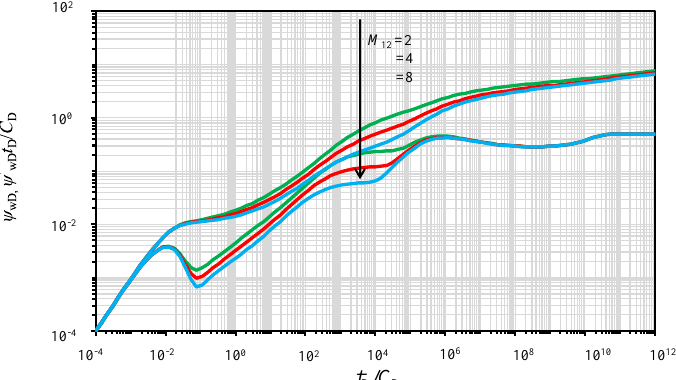
Figure 8. Effect of the ratio of the permeability in the SRV to that in the un-stimulated region on the pseudo pressure response (PPR) and pseudo pressure derivative (PPD).